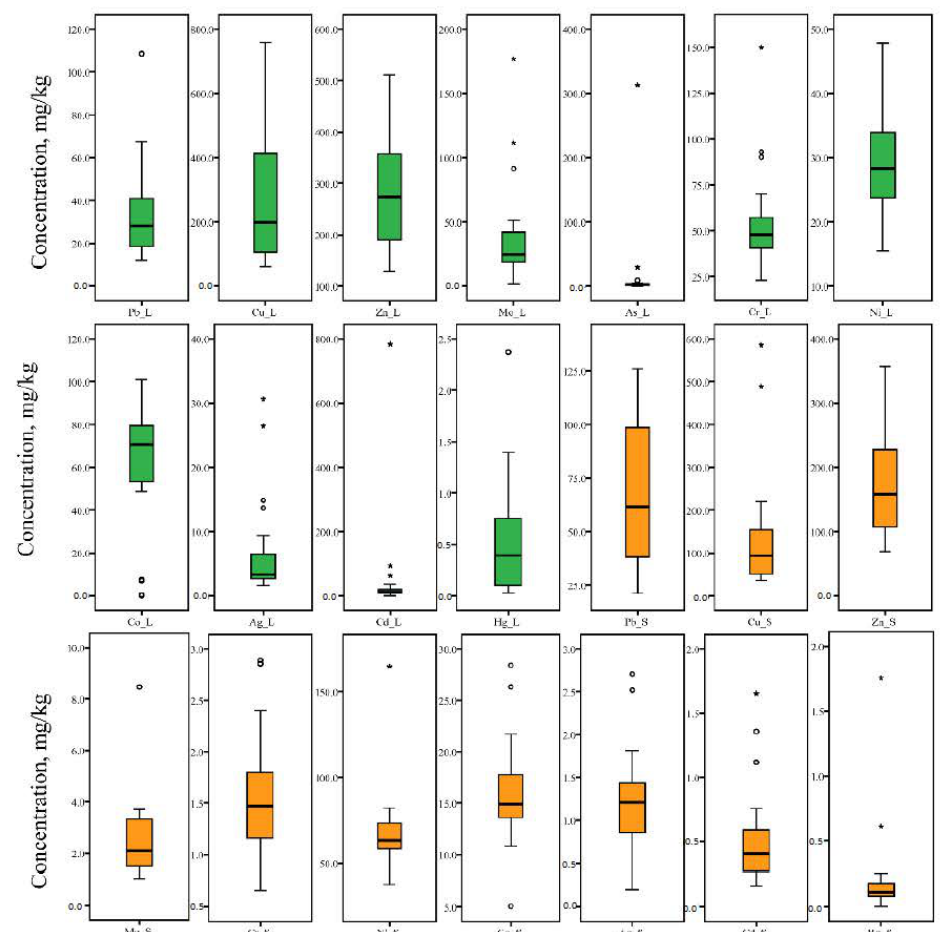
Figure 2. Box plots of studied PTE concentration in Yerevan’s tree leaf-deposited PM and soil (o—outliers and *—extreme values; for a better visualization, the extremely high content of Mo in sampling site 6 was